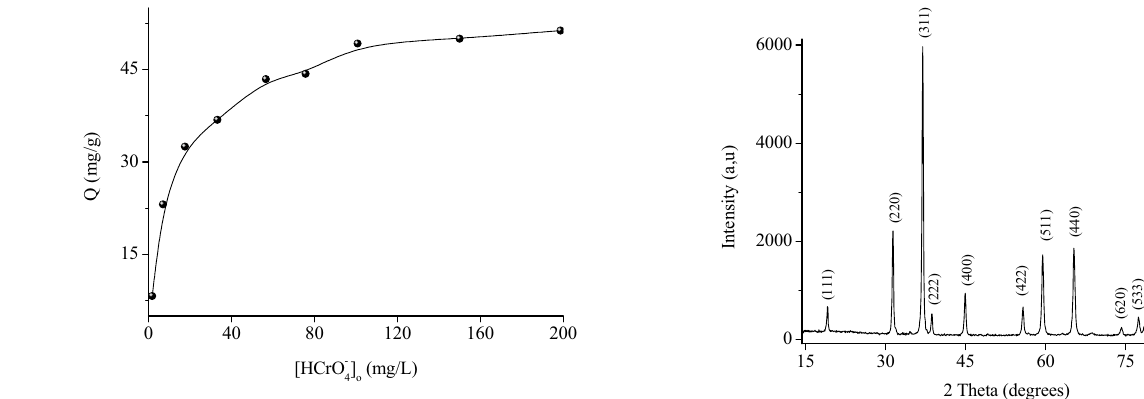
2 O 4 prepared by sol–gel and